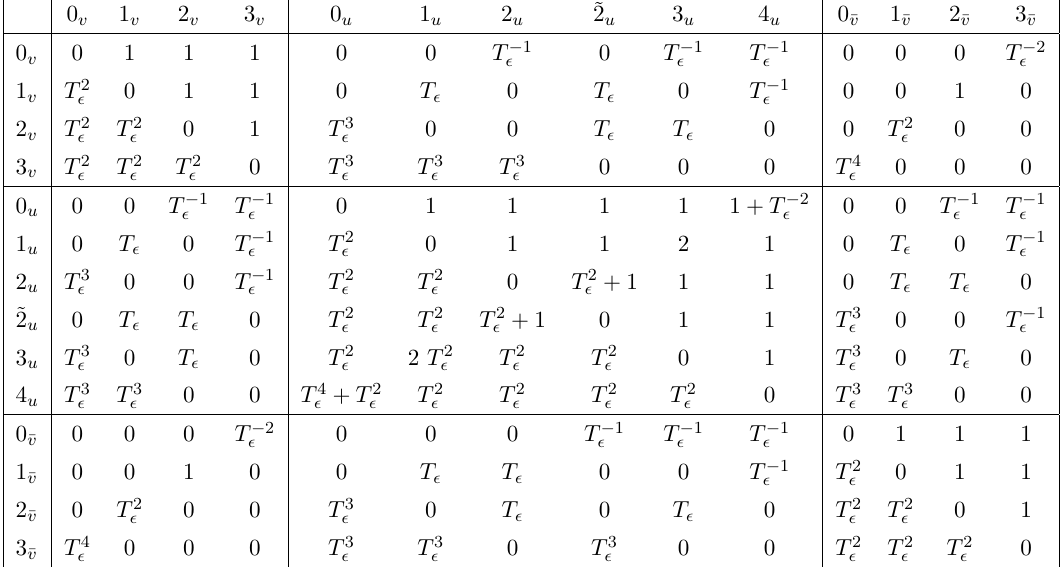
Table 5 . Gives X ( T a , λ | T b , µ ) with T a T − 1